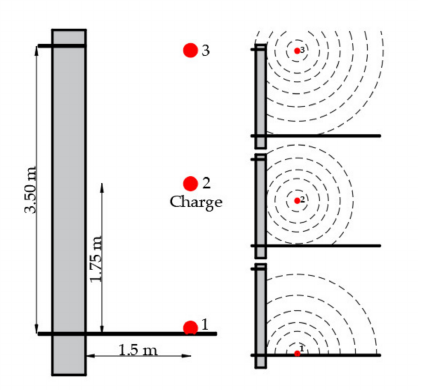
Figure 22. Shock wave propagation depending on the position of the explosive